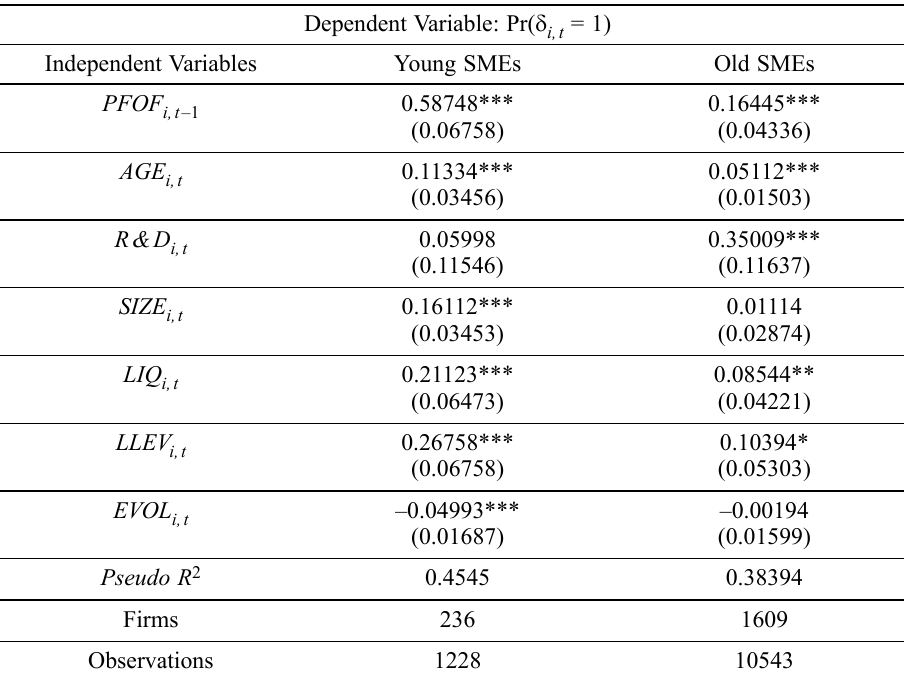
Table A1. Analysis of survival – Young SMEs and Old SMEs – alternative criterion for selecting SMEs based on